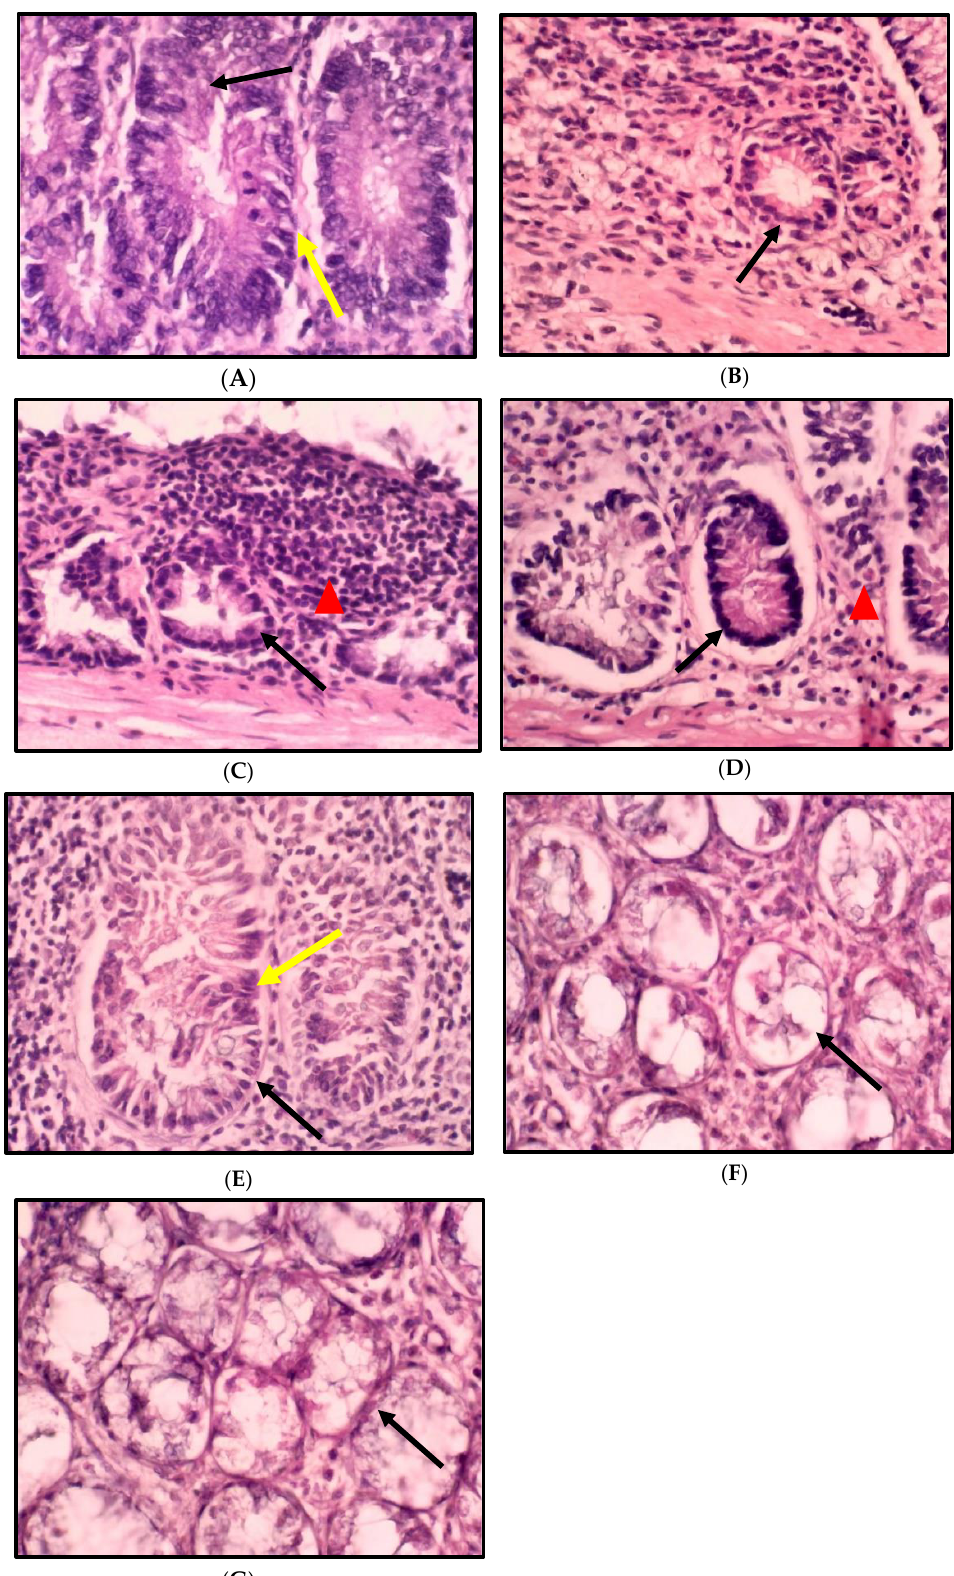
Figure 3. Cross-section of the rat colon stained with haematoxylin and eosin: ( A ) NC, normal diet + DMH; ( B ) H, high-fat diet; ( C ) HC, high-fat diet + DMH; ( D ) HCF, high-fat diet + DMH + 5-FU; ( E ) HCAP125, high-fat diet + DMH + 125 mg/kg A. paniculata ethanol extract; ( F ) HCAP250,